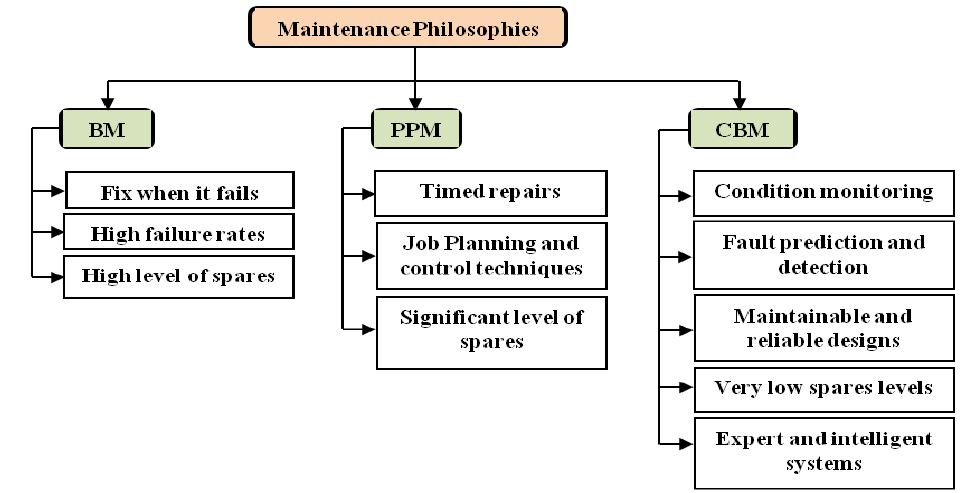
Figure 1. Main classes of maintenance philosophies and their respective characteristics.